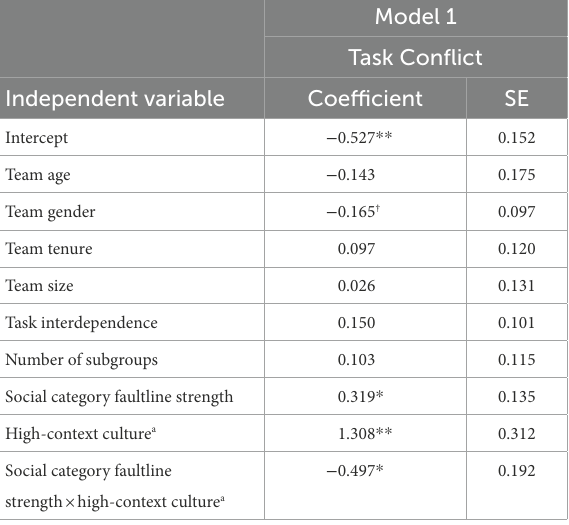
TABLE 2 Results from OLS regression analysis: task